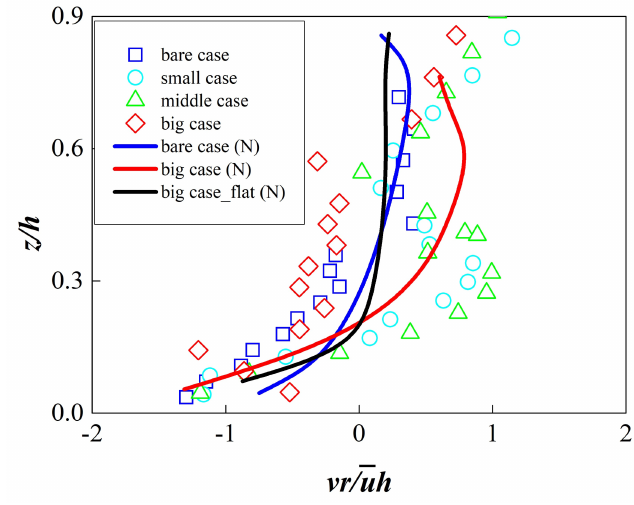
Figure 13. The transverse velocity distribution for experimental results (symbols) and numerical simulations (solid